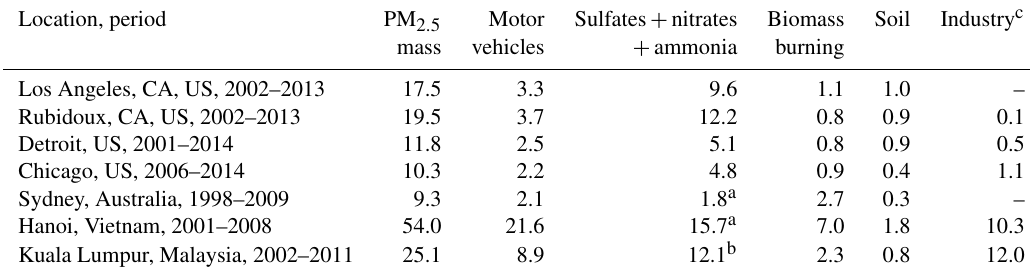
Table 2. Comparison of long-term source-apportionment studies carried out in urban areas. Location,